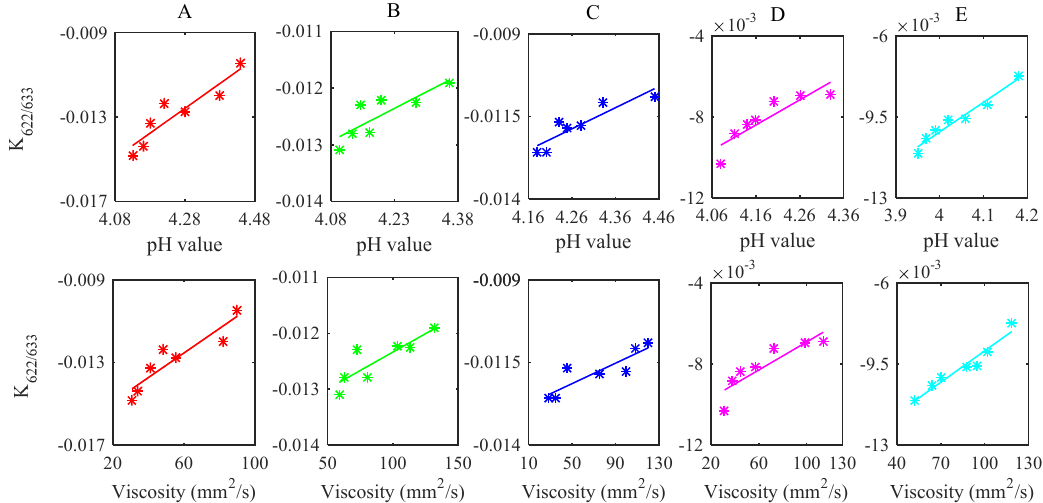
Figure 6. The relevance of fluorescence peak ratio K 622/633 with pH value and viscosity of yogurt during the whole measurement series.